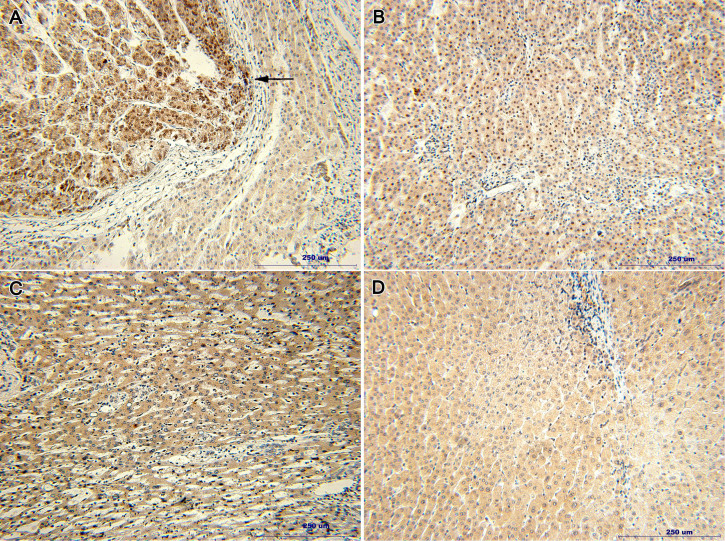
Gradual changes in the level and pattern of Gankyrin expression during the successive stages of hepatocarcinogenesis, as determined using IHC.(A) Gankyrin staining was strong in both the cytoplasm and nucleus of HCC cells (arrow). (B) Gankyrin was moderately expressed in both the cytoplasm and nucleus of AH cells. (C and D) In contrast, Gankyrin was weakly expressed in the cytoplasm of hepatocytes and occasionally expressed in the nucleus of hepatocytes in chronic hepatitis (C) and cirrhosis (D) tissues.